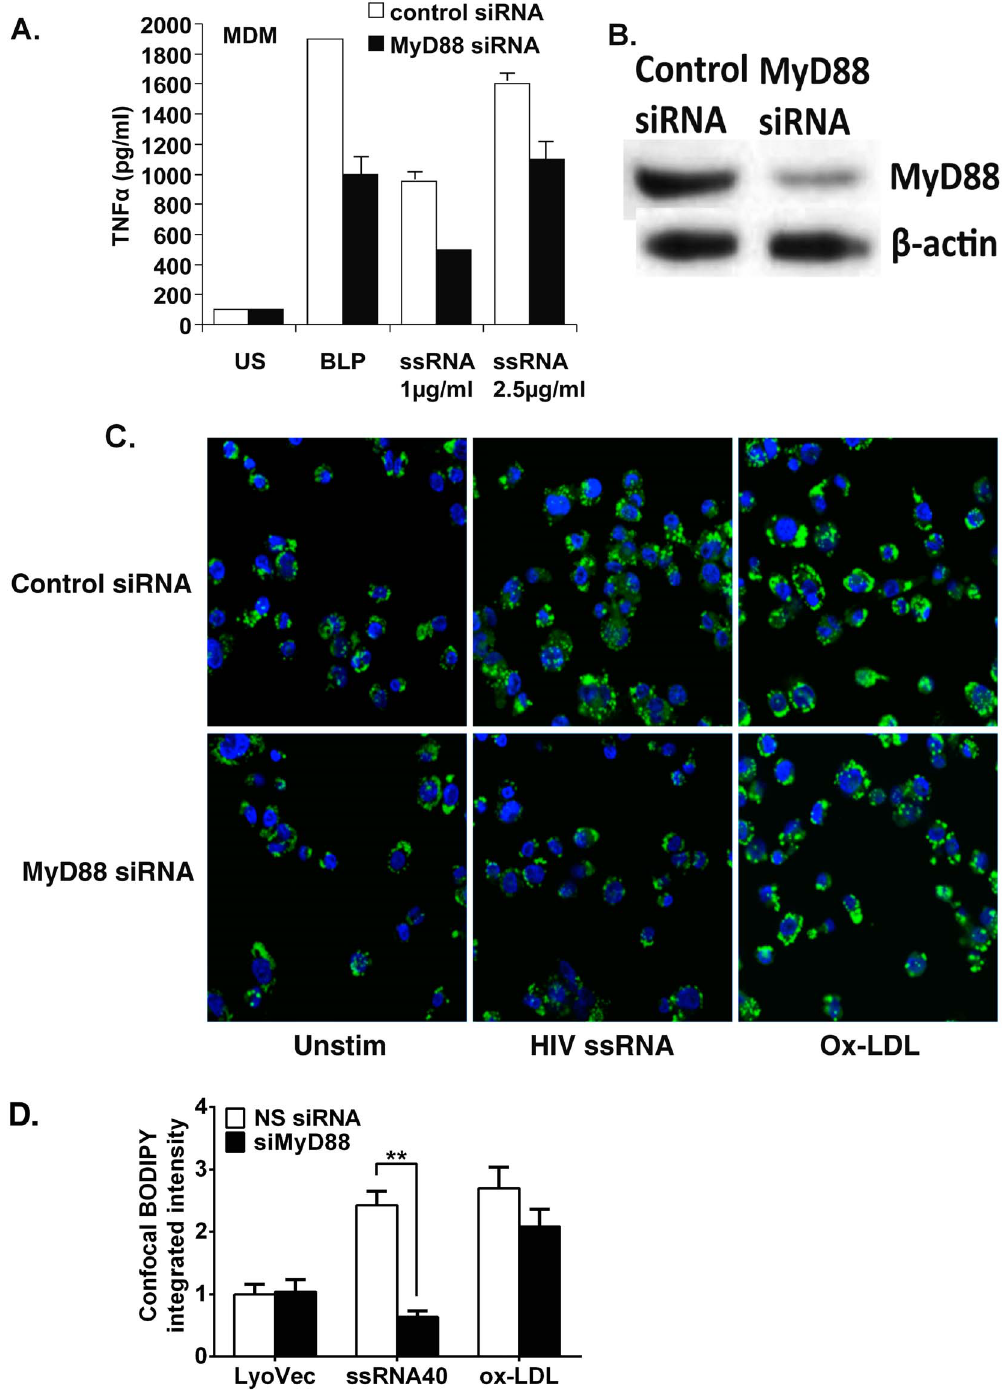
Figure 7. Induction of foam cell formation in MDMs by HIV ssRNA is dependent on MyD88. MDMs were pretreated with MyD88 siRNA and nonsilencing control. Cells were challenged with HIV ssRNA or ssRNA control and incubated for 24 h. Cell free supernatants were assayed for TNF a by ELISA ( A ) and BODIPY staining ( C ). Western blot analysis of MyD88 after gene silencing with the use of MyD88 siRNA and nonsilencing siRNA control. b -actin was used to monitor loading after stripping the membrane ( B ). Bar graph shows integrated fluorescence intensities of BODIPY per cell of the confocal micrographs ( D ). A representative blot shows results from one experiment with similar results obtained in four independent experiments.